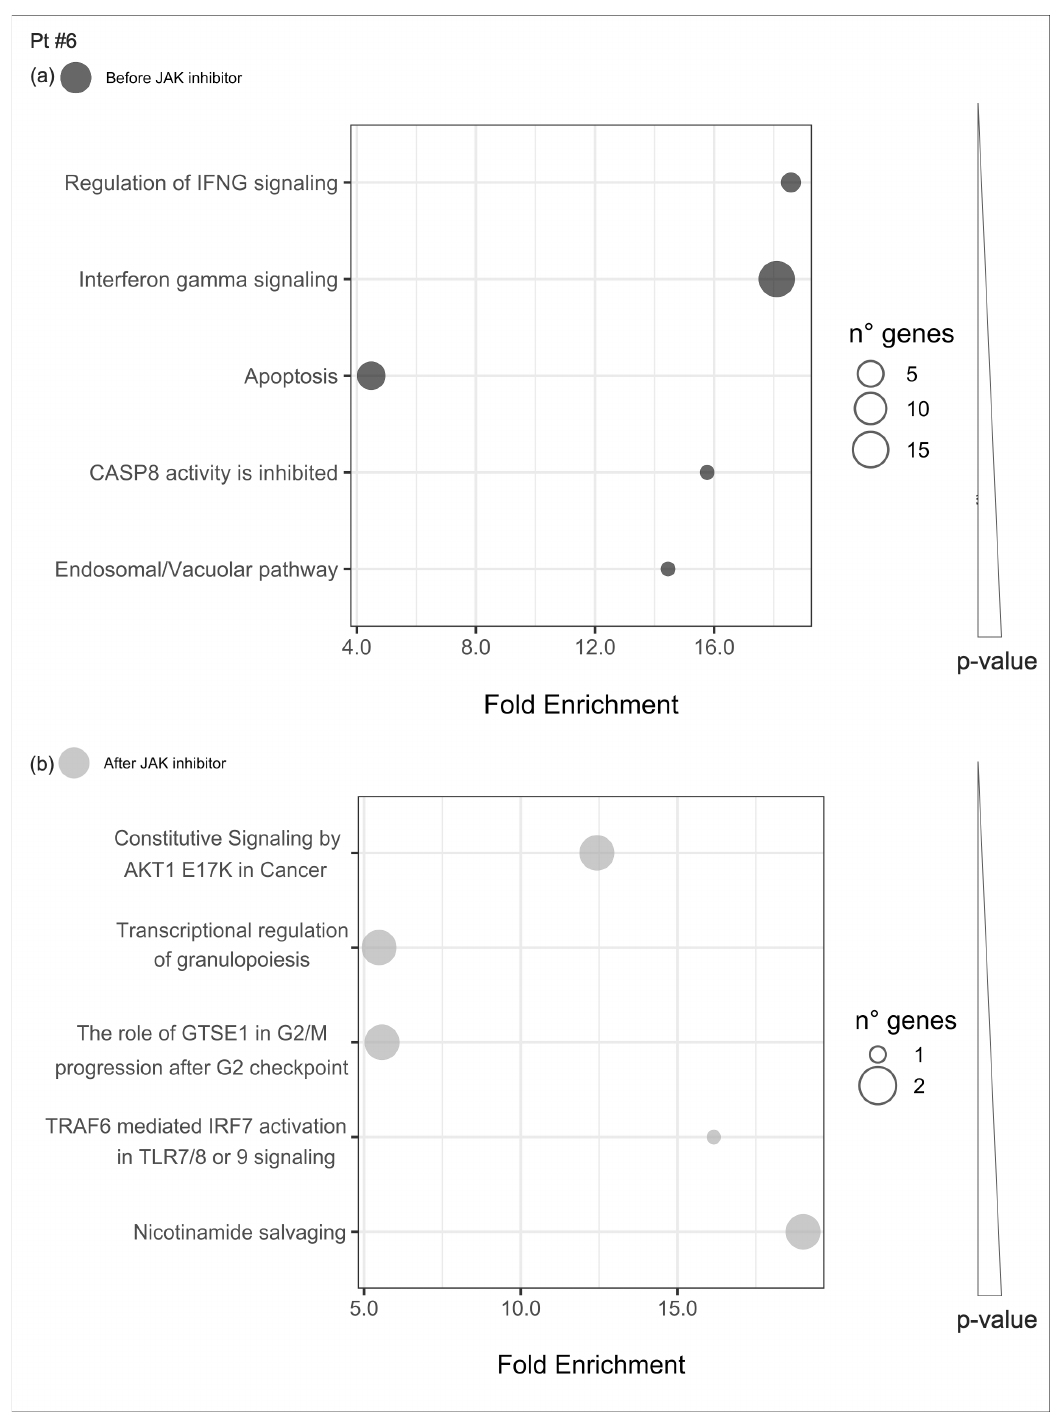
Figure 13. Pathway enrichment analysis was run on di ff erential expressed genes resulting from the comparison between patient #6 before JAKinhibs and the control-group subjects, and between patient #6 after JAKinhibs and the controls. Pathways altered uniquely before ( a ) or uniquely after ( b ) JAKinhibs were chosen. Each dot represents a pathway, and the size is directly proportional to the number of genes. On the X -axis the pathway fold enrichment is displayed. All the selected pathways showed a lowest adjusted p -value of the given term over all iterations ≤ 0.01, and the five most enriched pathways were elected, where applicable. Pathways are ordered by increasing p -values. Pathways altered before JAKinhibs are colored in dark grey and those altered after JAKinhibs in light